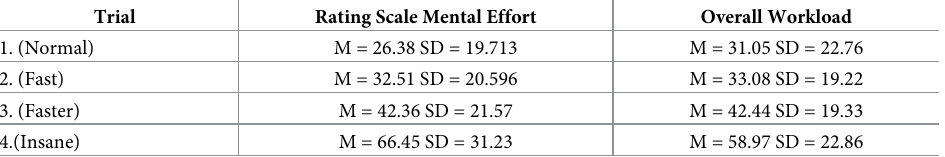
Table 1. Self-report measures by trial.